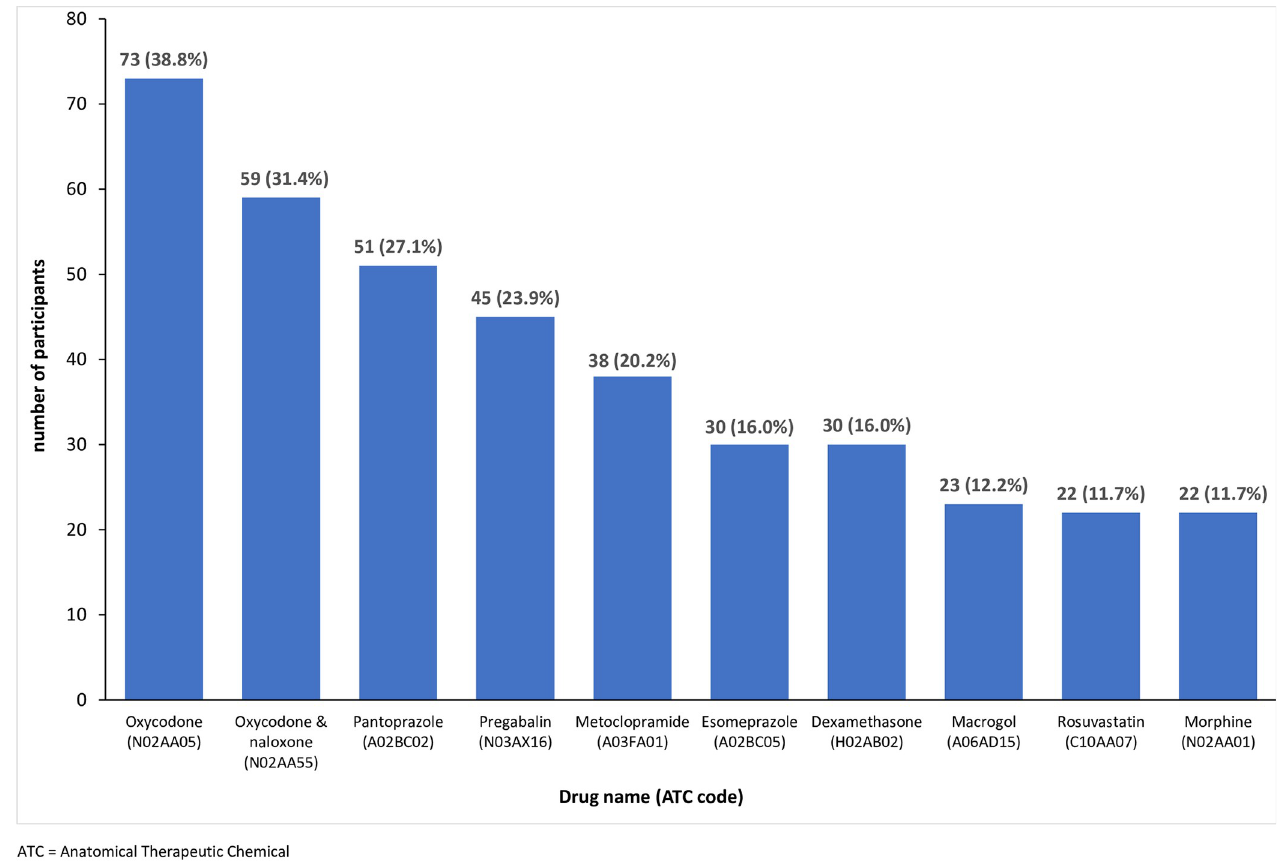
Fig 1. Top 10 most frequently prescribed